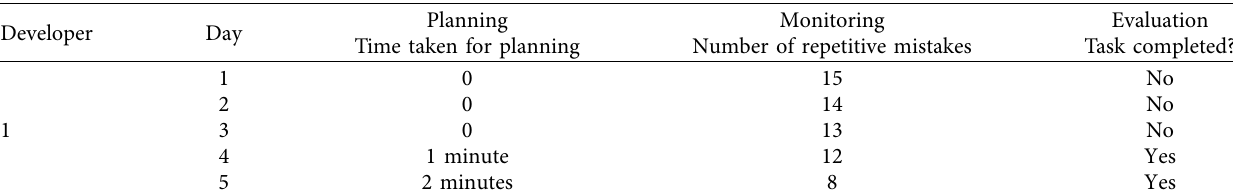
Table 3: Developer planning, monitoring, and evaluation data from the Devskiller log.